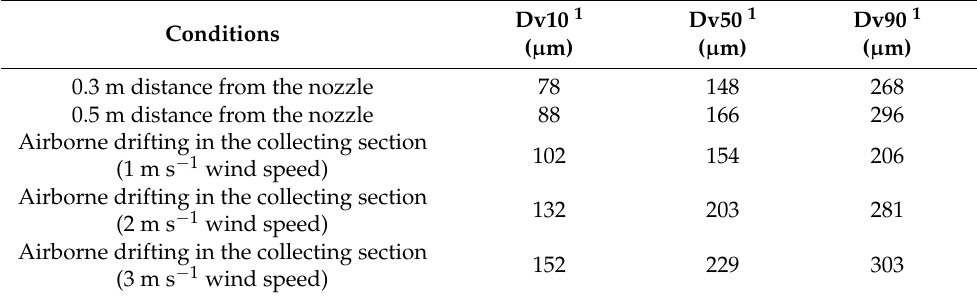
Table 1. Size distribution of droplets sprayed from the nozzle (measured by a laser-based analyser) and airborne droplets drifting in the collecting section (measured by water-sensitive